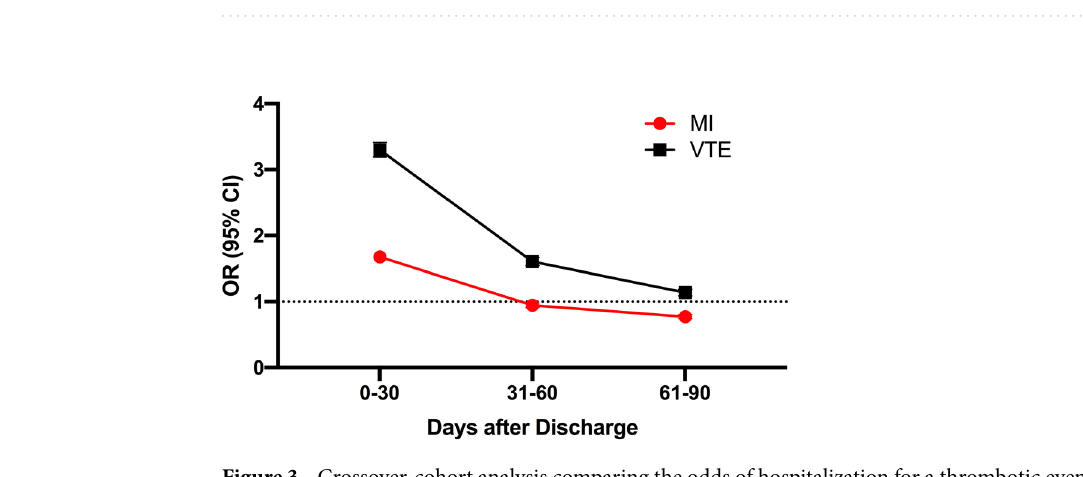
Table 2. Crossover-cohort analysis comparing the risk of thrombotic events in the 30-day period after discharge following respiratory infection versus the 30-day period ending 7 days prior to admission for respiratory infection. † Unweighted counts and proportions. *Conditional logistic regression of unweighted data for case-cohort analysis.